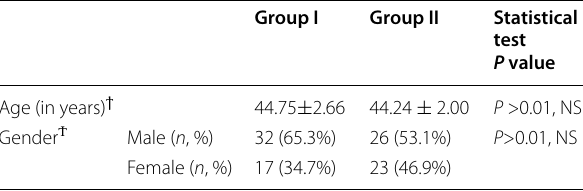
Table 1 Mean age and gender distribution of the study participants